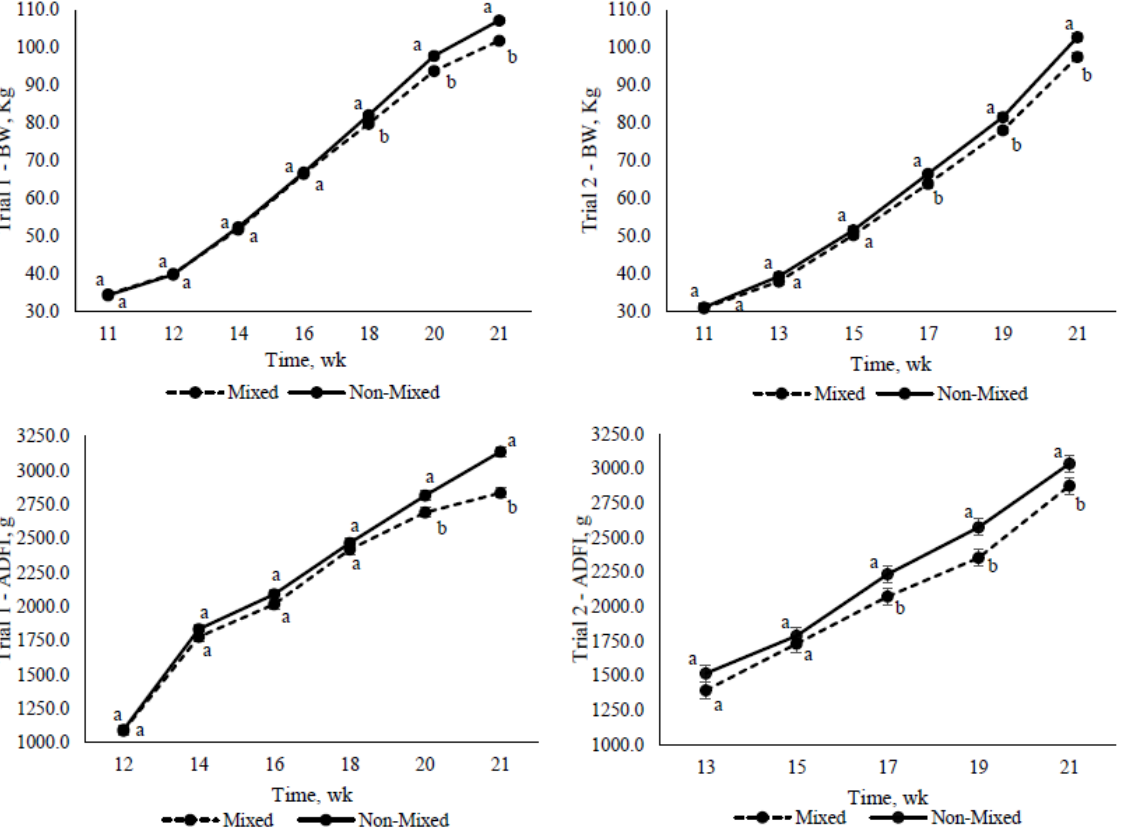
Figure 2. Effect of mixing on body weight (BW) and average daily feed intake (ADFI) in trial 1 and trial 2 (n = 5) from 11 to 21 weeks of age, when the first group of pigs reached 110 kg of BW and were sent to slaughter; a–b Significant differences between groups ( p < 0.05).